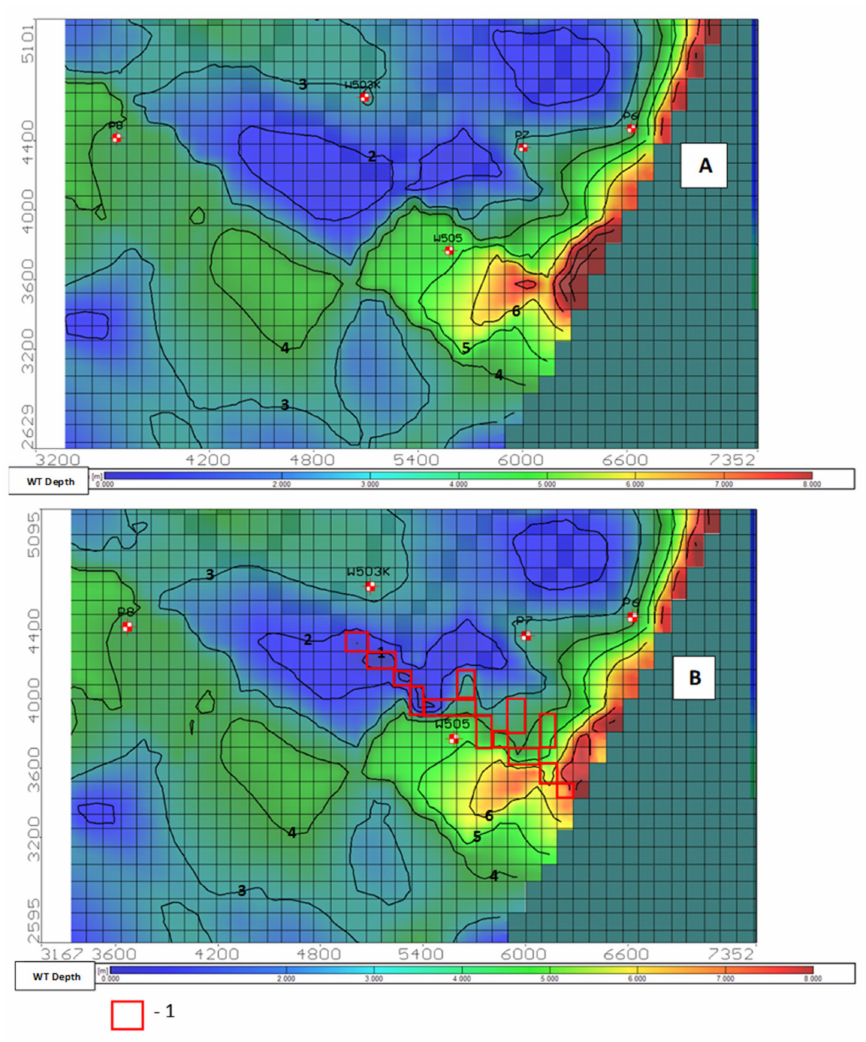
Figure 11. Groundwater table depth for the end of the growing season (October): ( A )—identification task; ( B )—prediction task; 1—model blocks represent the additional recharge zone, instead of the “drain” boundary